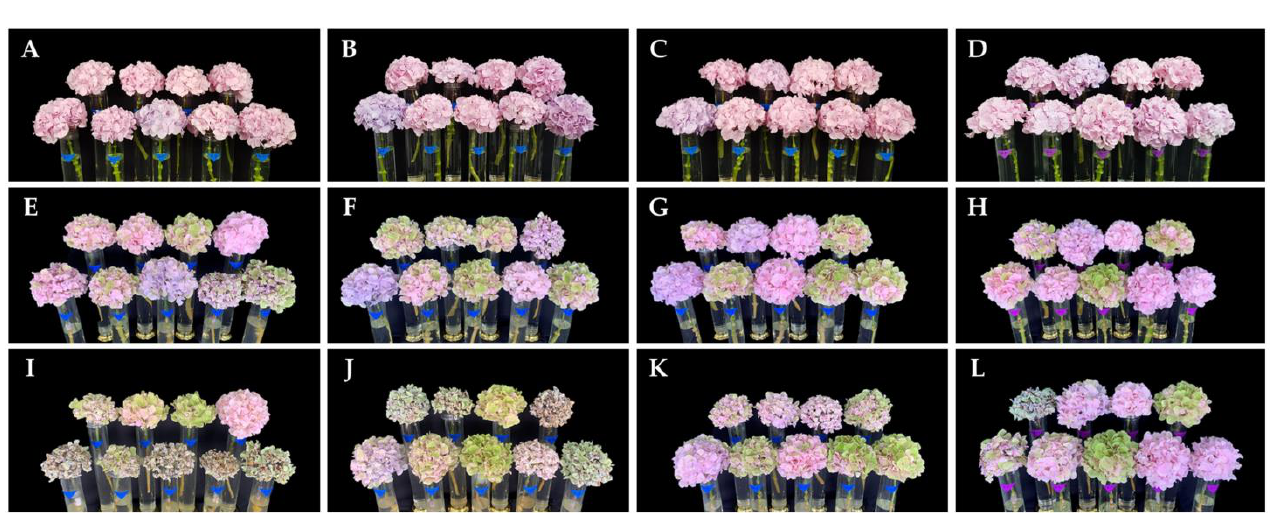
Figure 6. Appearance of cut hydrangea flowers ‘Verena’ by solution combination for each postharvest treatment stage in 2020. ( A – D ): First day after preservative solution, ( E – H ): 22nd day after preservative solution, ( I – L ): 29th day after preservative solution ( A , E , I ): TW–TW–CPIII, ( B , F , J ): TW–CPIII–CPIII, ( C , G , K ): RVB–CPIII–CPIII, ( D , H , L ): Table 4. Vase life and main factor of senescence of cut hydrangea flowers ‘Verena’ by solution combination for each post- harvest treatment stage in 2020.